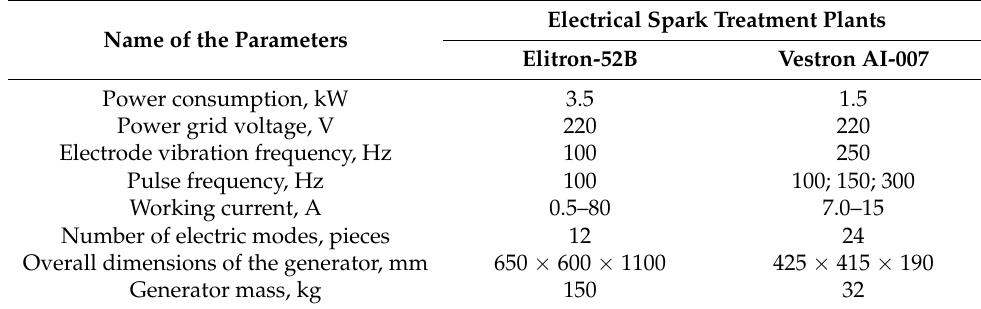
Table 1. Technical characteristics of the Elitron-52B and Vestron AI-007 (GOSNITI, Moscow, Russia) electric spark generators.